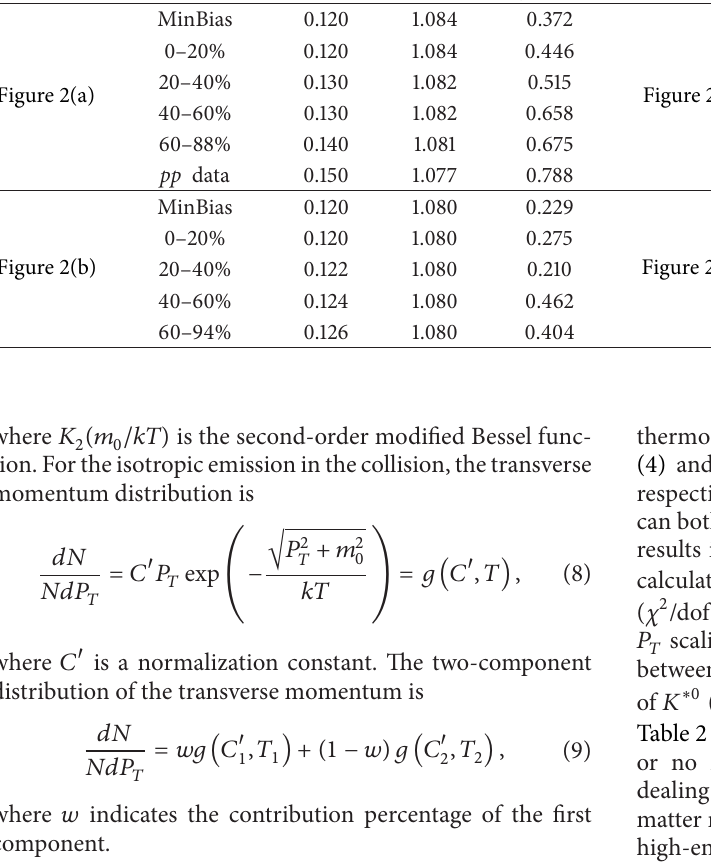
Table 2: Values of 𝑇 , 𝑞 , 𝑇 󸀠 , and 𝑞 󸀠 taken in Figure 2. 𝑇 and 𝑇 󸀠 units are GeV. Figure Centrality Figure